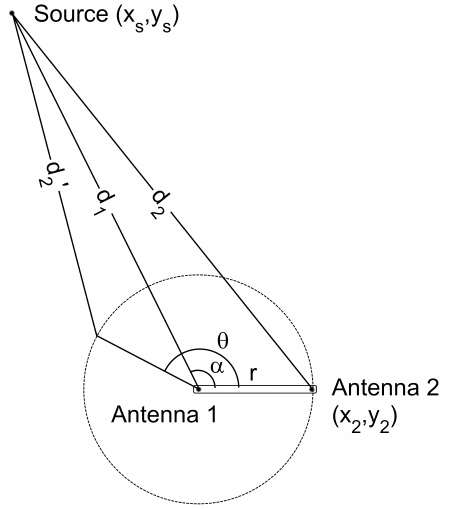
Figure 3. Source and antenna positions to determine the analytic expression of the periodic function θ vs